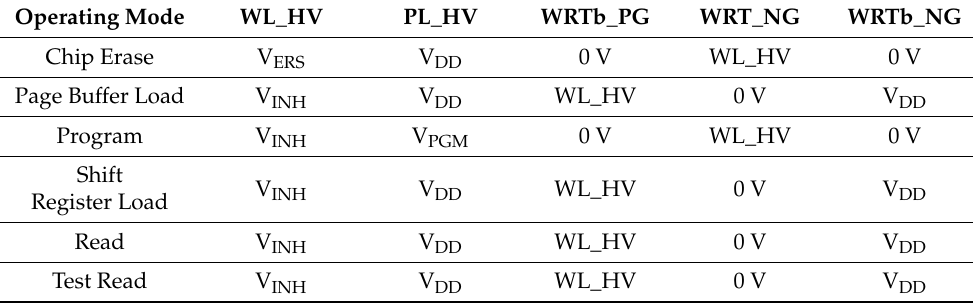
Table 4. Output voltages of HV switching circuit for each operation mode.